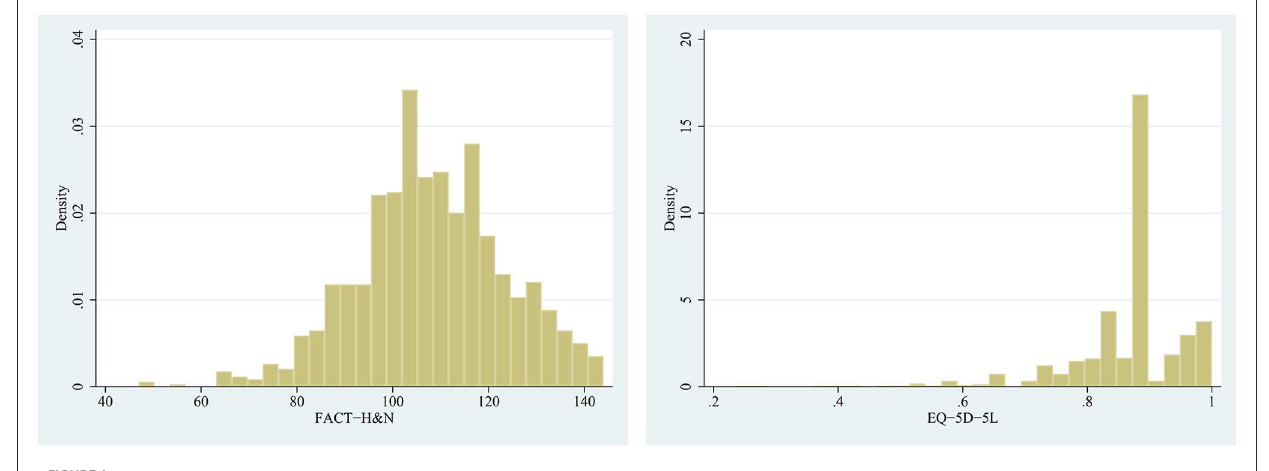
FIGURE1 Histograms of the FACT-H&N and the EQ-5D-5L scores.